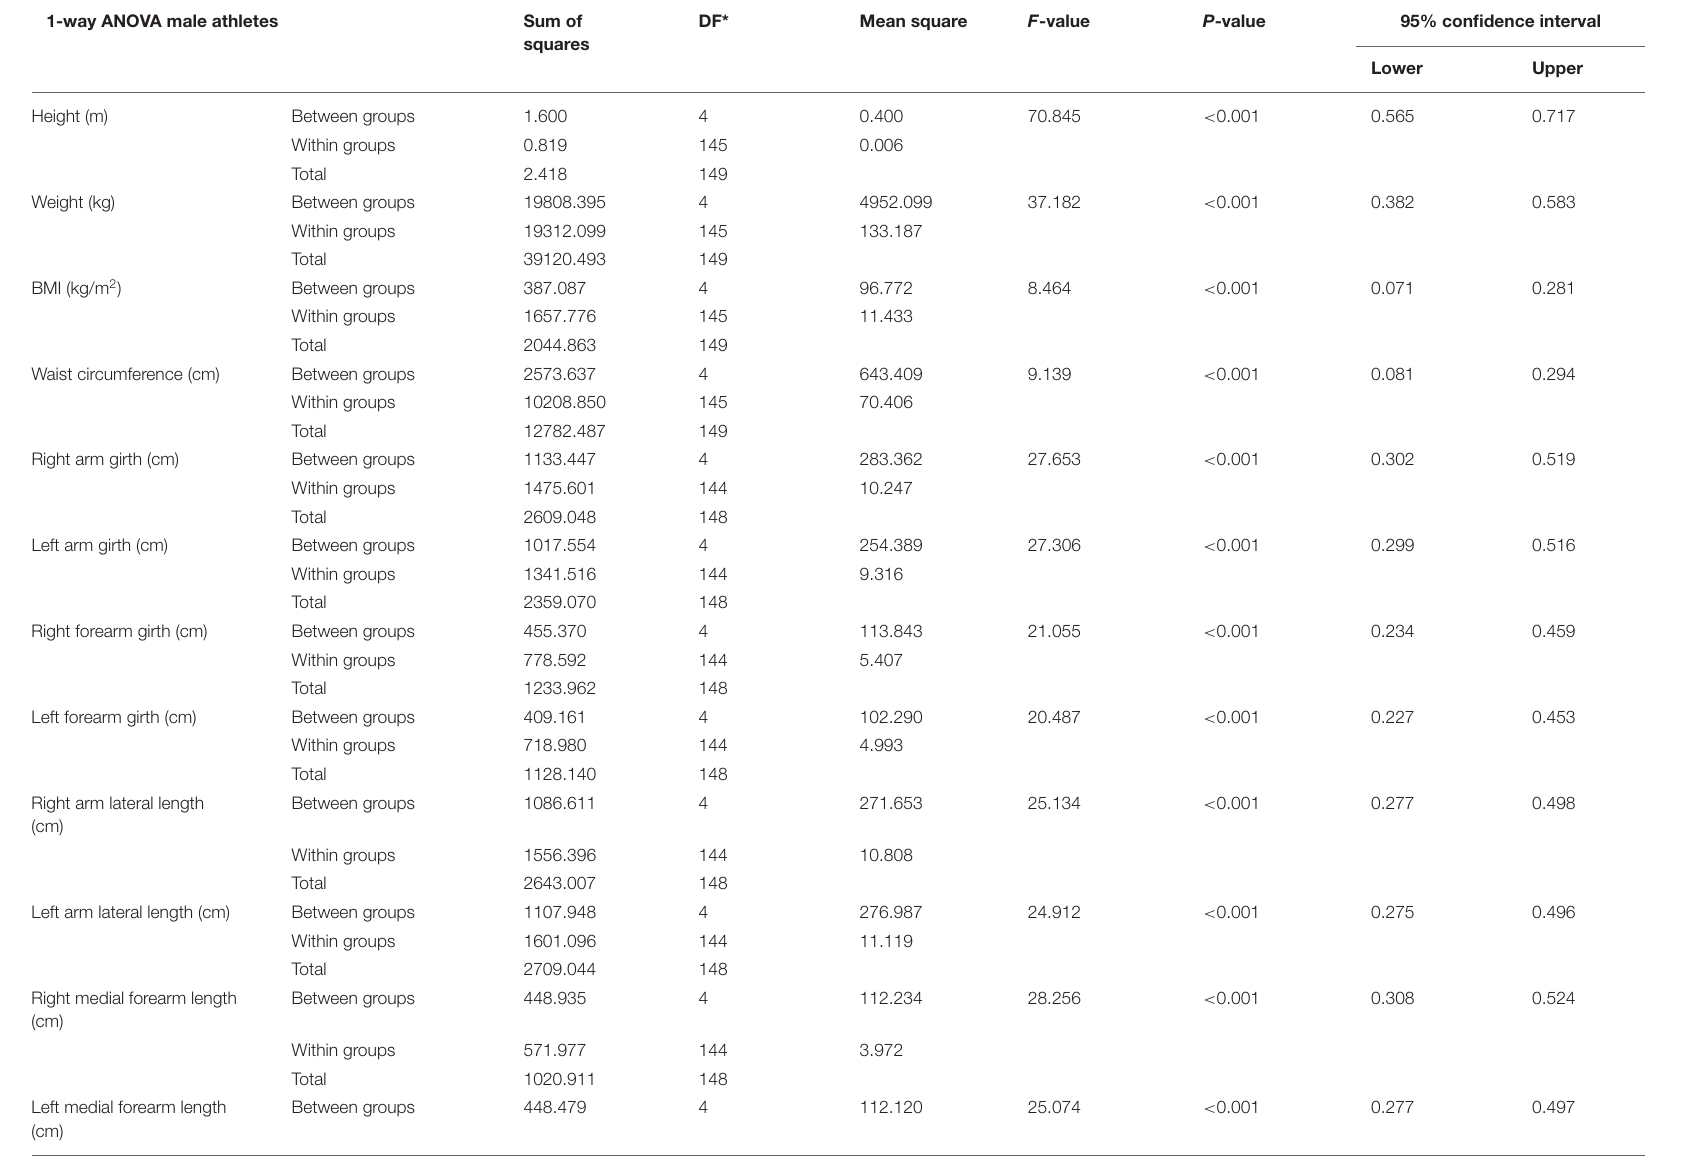
TABLE 5 | 1-way ANOVA for male athletes. 1-way ANOVA male